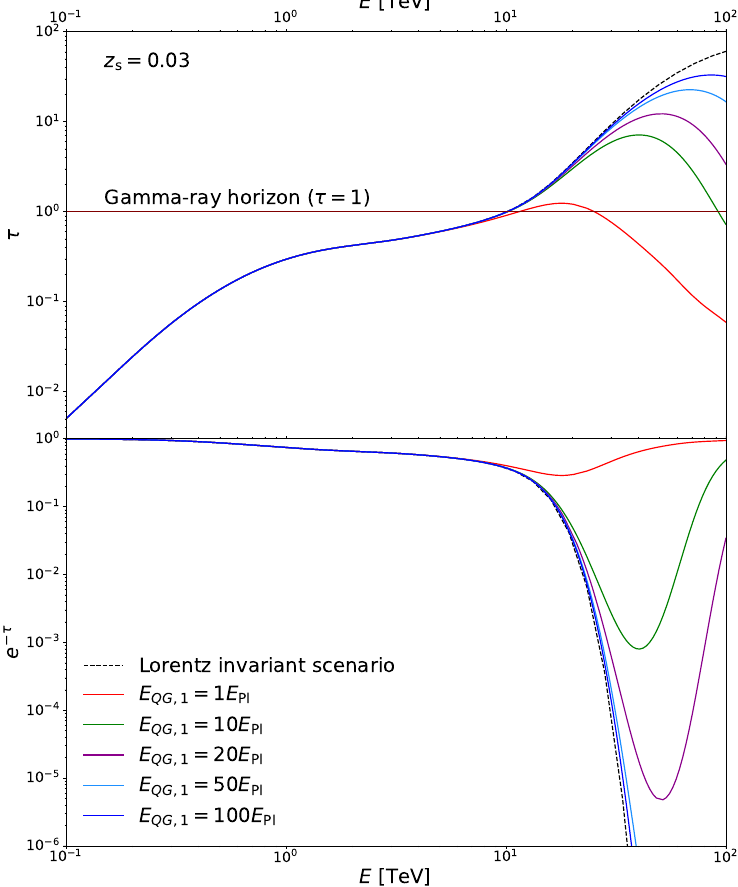
Figure 3. ( Top ) Optical depth ( τ ) as a function of a gamma-ray energy ( E ) for a hypothetical source at z s = 0.03. The black dashed line represents the Lorentz invariant scenario, while solid lines represent LIV subluminal scenario. Five different values of E EG,1 were considered. Gamma-ray horizon is denoted with the maroon line. ( Bottom ) The absorption coefficient ( e − τ ) as a function of a gamma-ray energy ( E )